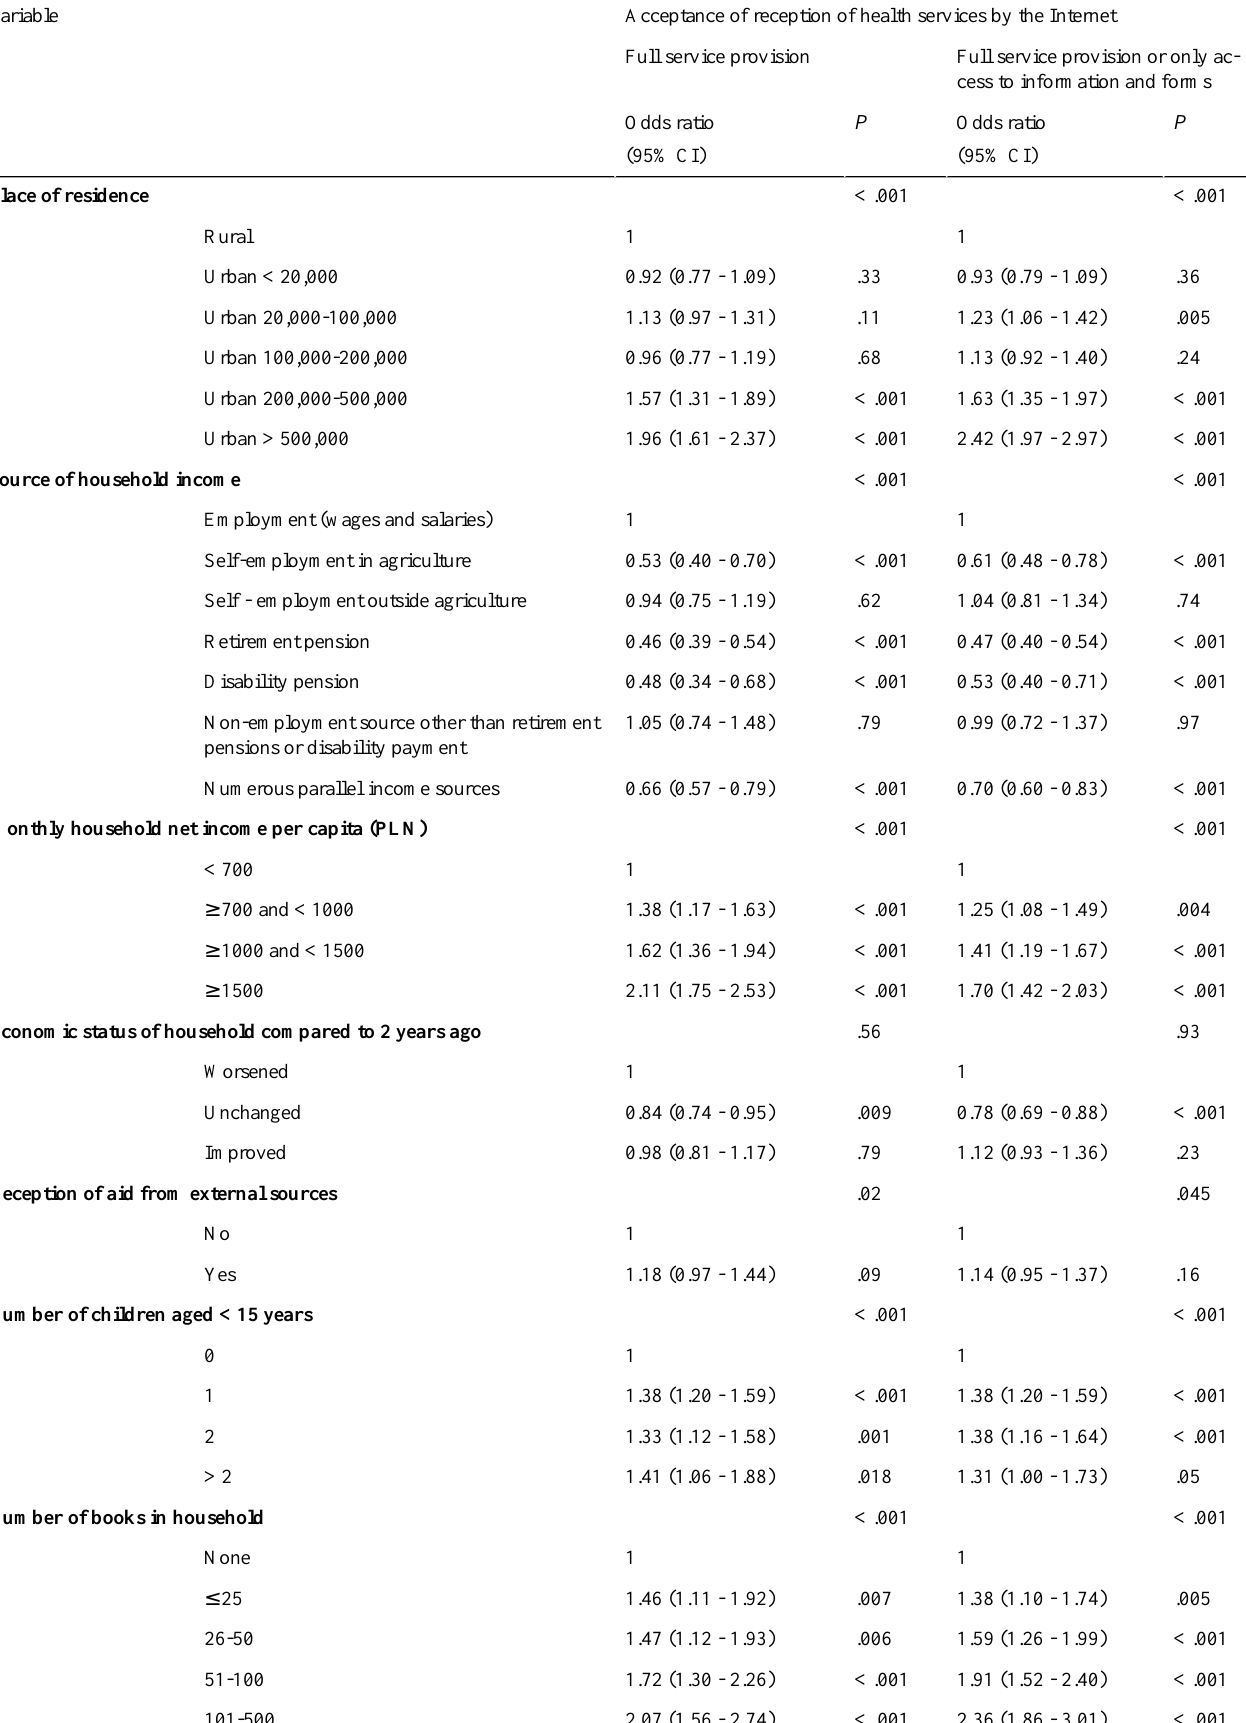
Table 2. The results of multivariate logistic regression model for factors affecting the acceptance of Internet-based health care services. Acceptance of reception of health services by the